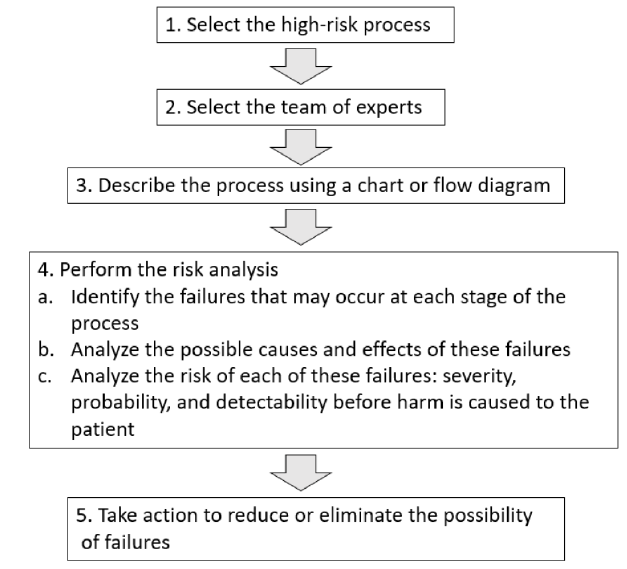
Figure 1. Steps involved in FMECA.